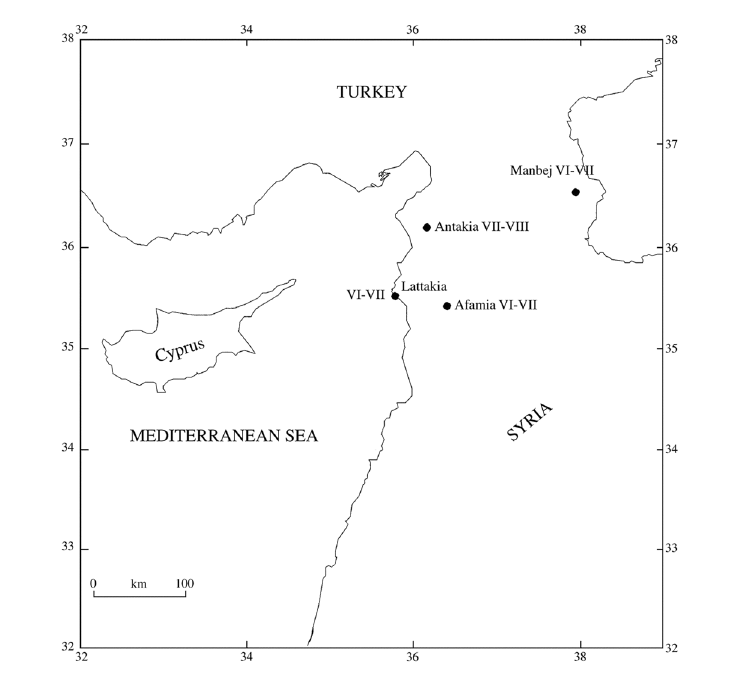
Fig. 15. Map of intensity distribution for the 53 A.D.